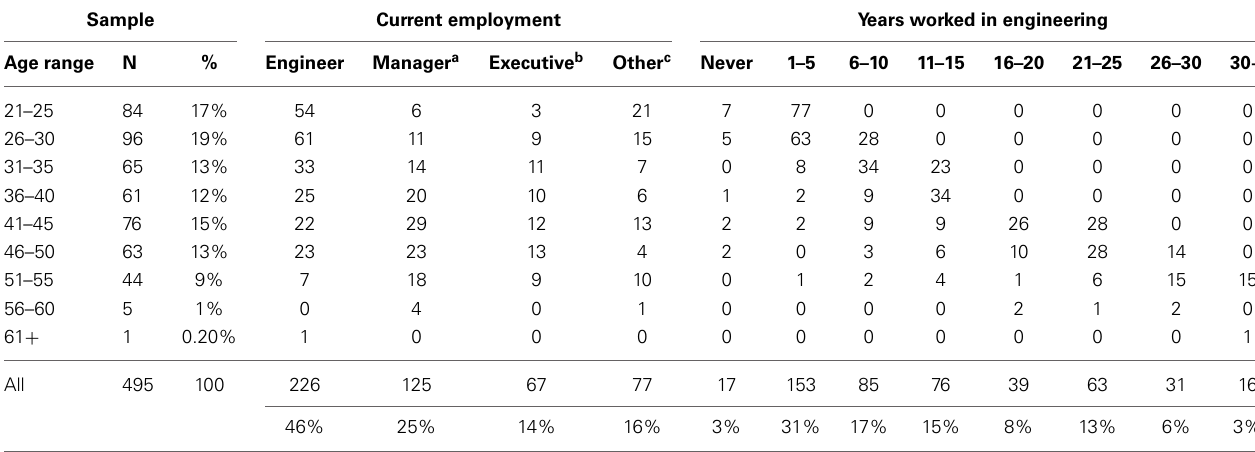
Table 3 | Employment statistics by age for women with engineering degrees.